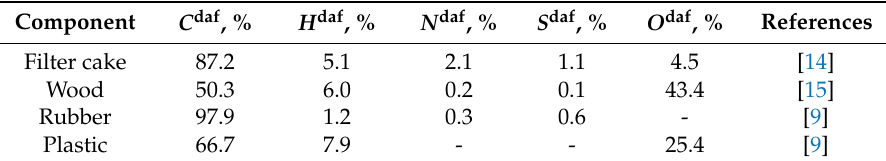
Table 3. Flash temperature and ignition temperature of fuel components.